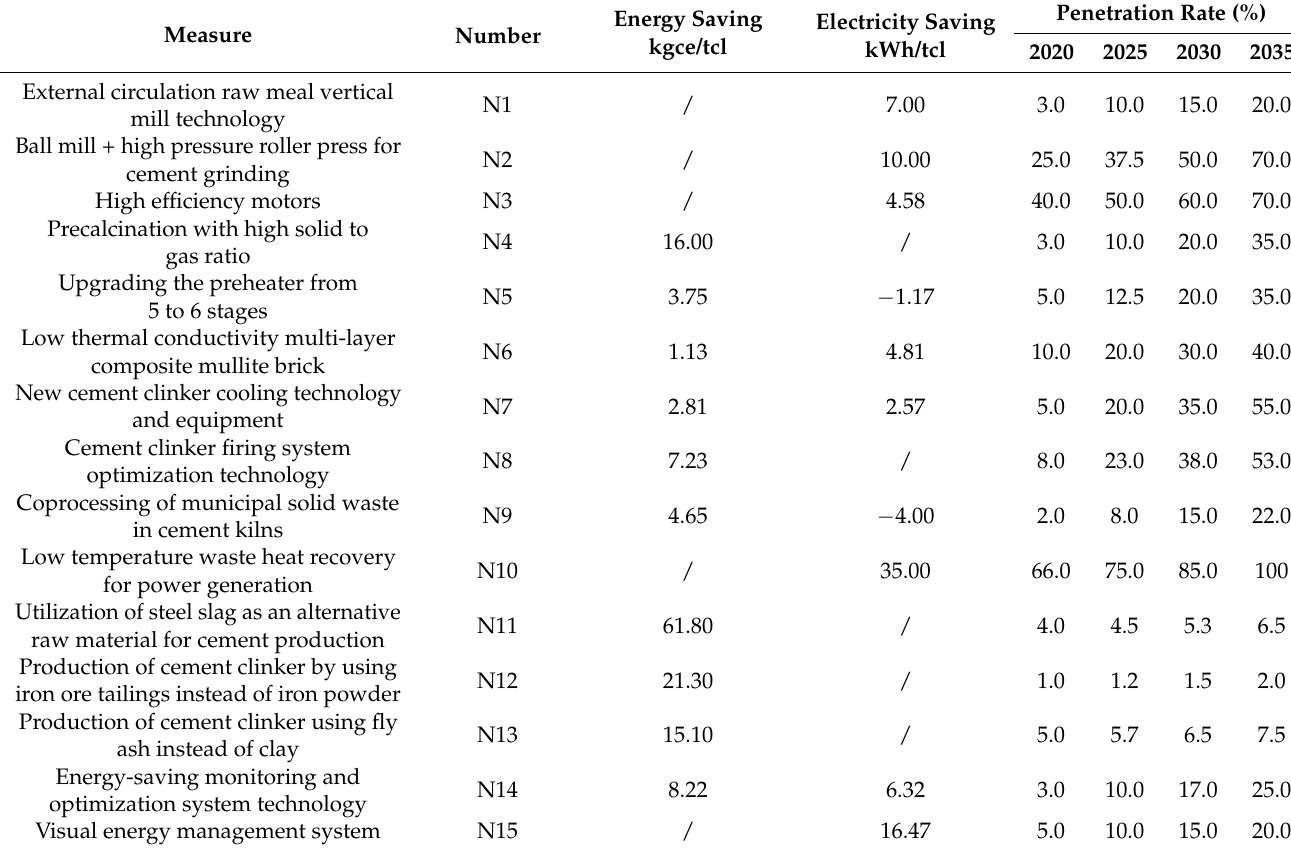
Table 7. Relevant parameters of low-carbon technical measures in the cement